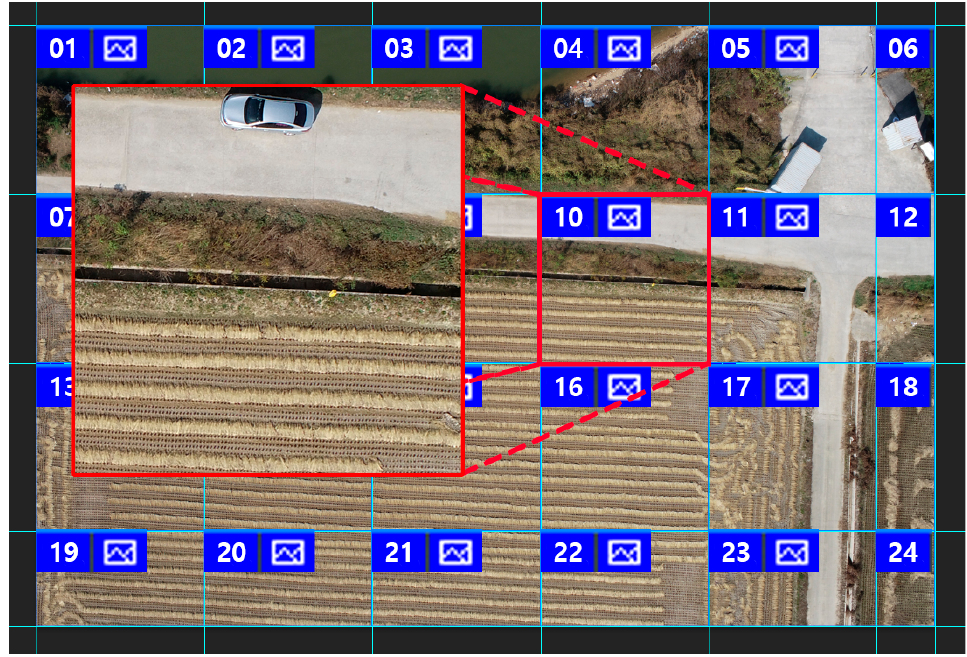
Figure 8. Image division.